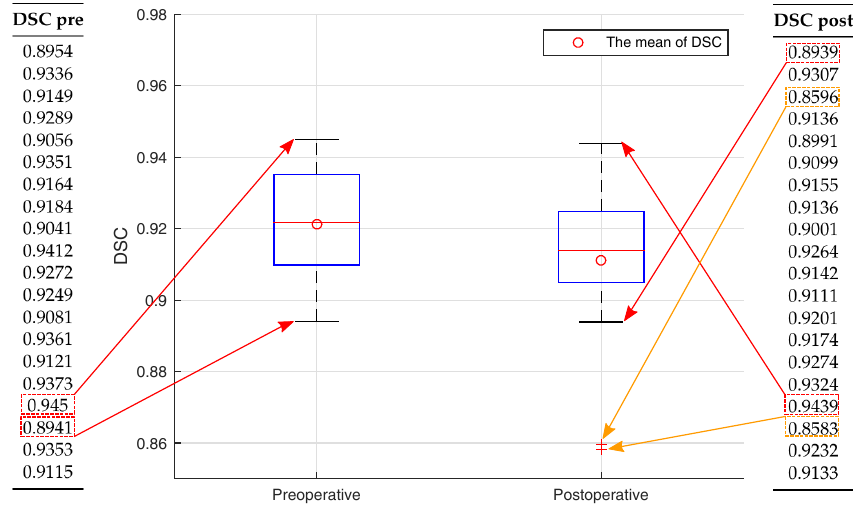
Figure 7. Distribution of DSC values of preoperative and postoperative segmentation data. (3) The ADE values were calculated and divided into three groups: general average, positive average and negative average. The whole results are presented in Table 2.